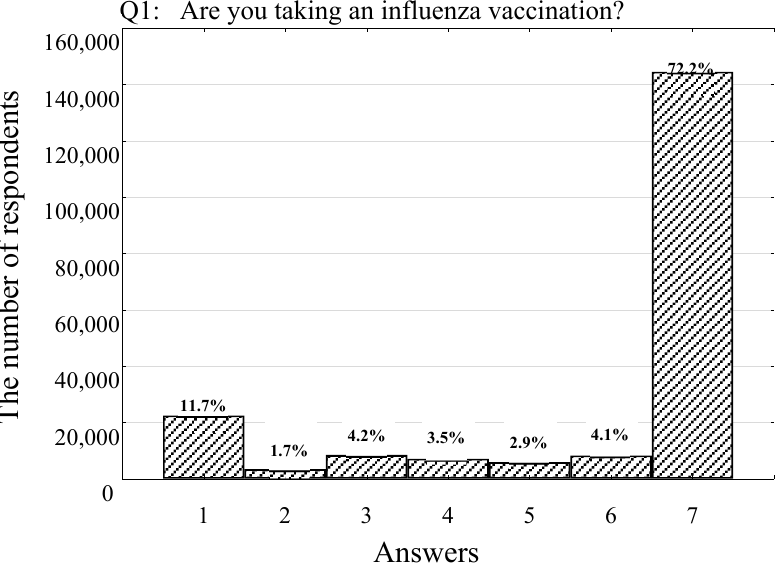
Figure 1. Number (percentage) of respondents declaring their attitude toward influenza vaccination among 200,000 Poles participating in the survey in 2022 (each point represents the answer shown in Table 2: 1—yes, every year, including in 2022; 2—yes, every year, but I couldn’t take an influenza vaccination in 2022 due to the lack of its availability; 3—yes, but not every year. I got the influenza vaccine in 2022; 4—yes, but not every year. I wanted to get a vaccine in 2022, but I couldn’t due to the lack of its availability; 5—usually not, but I got the influenza vaccine in 2022; 6—usually not. I wanted to get a vaccine in 2022, but I couldn’t due to the lack of its availability; 7—no, never). Due to the observed positive relation between the attitude to COVID-19 vaccination and influenza vaccination (rho = 0.219, p < 0.001), we were able to determine how these approaches were changing under the influence of each other. Among those vaccinated against COVID-19, the number of respondents regularly taking an influenza vaccination increased from 11.3% (Table 2) to 13.3% (Figure 2). Furthermore, among those denying the COVID-19 vaccination, only 0.7% of them declared taking an influenza vaccination, including in